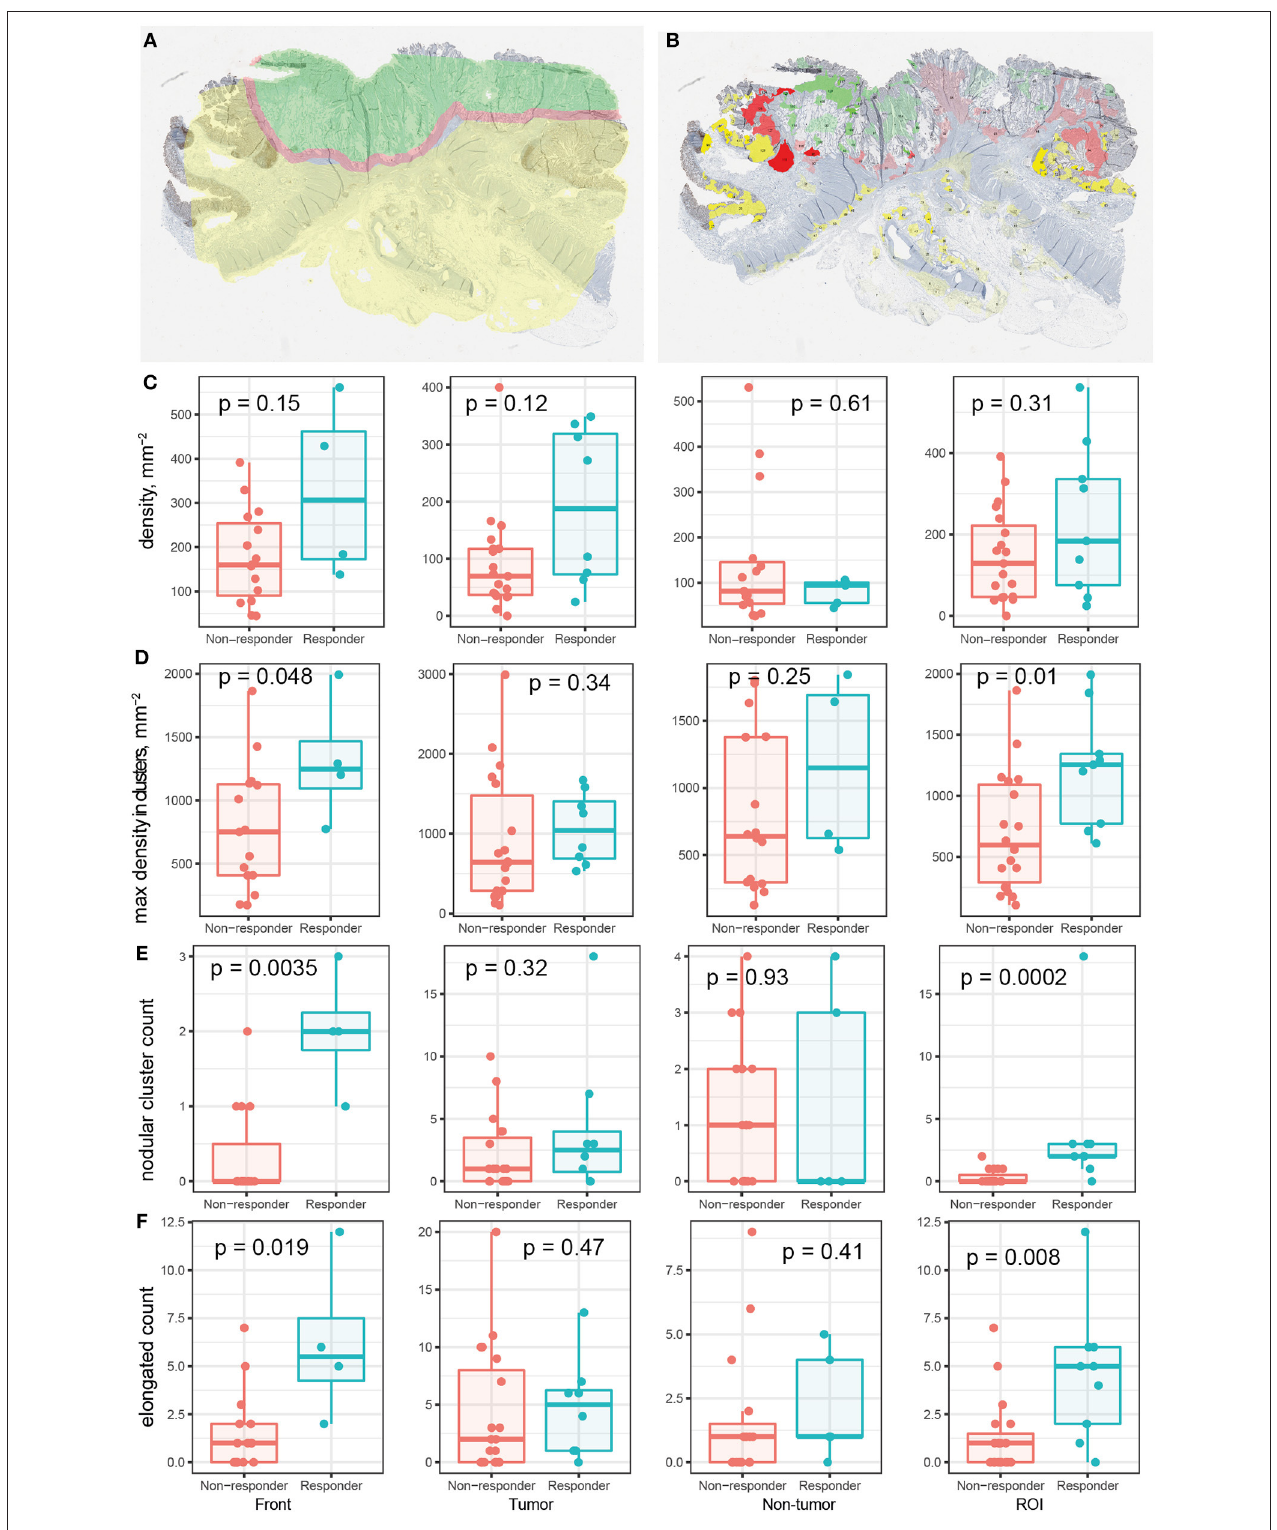
FIGURE 8 | Relationship between region specific metrics and responsiveness to immune checkpoint blockade therapy. (A) Patient tissue annotation. Green: tumor; yellow: normal tissue; red: invasive front. (B) CD8 T cell cluster tissue association. Transparency indicates density in each cluster. (C–F) Various metrics in different + tissue regions for responders vs. non-responders. (C) Average CD8 T cell density. (D) Maximum cluster density. (E) Number of circular clusters. Criteria: eccentricity + < 0.8 AND convexity > 0.8 AND circularity > 0.5. (F) Number of elongated/irregular clusters. Eccentricity > 0.9 OR convexity < 0.3 OR circularity < 0.3.